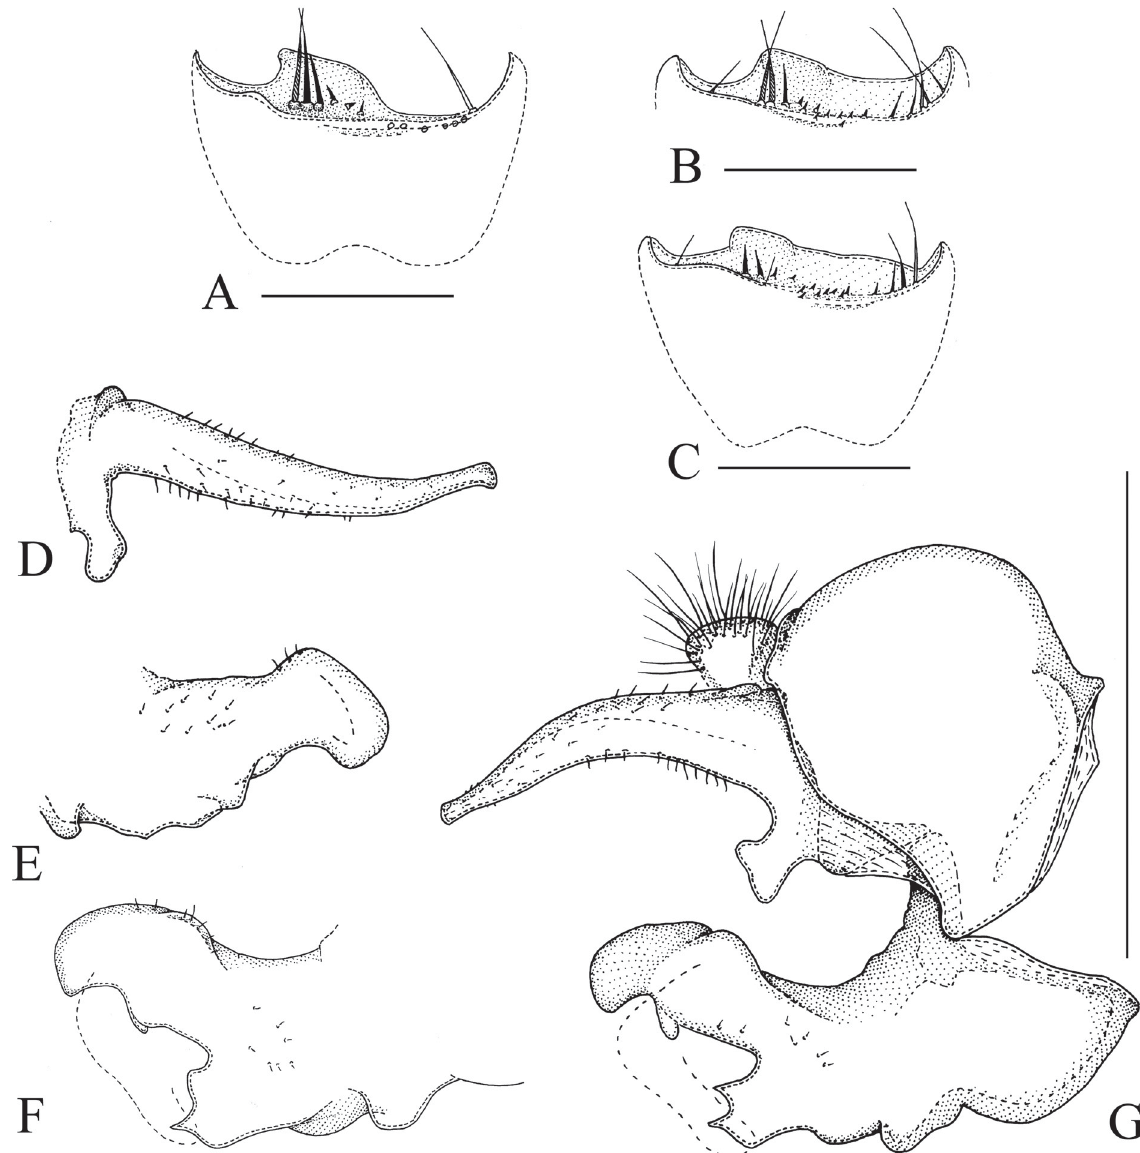
Fig. 57. Sphegina (Asiosphegina) lobulata sp. nov., holotype, ♂ (A, D, E, G), paratype, ♂ Tam Dao 1 (C, F) and paratype, ♂ Tam Dao 2 (B). A–C . Sternum IV, ventral view. D . Left surstylus, lateral view. E . Left s uperior lobe with associated parts, lateral view. F . Right superior lobe with associated parts, lateral view. G . Genitalia, right side, lateral view. Scale bars =